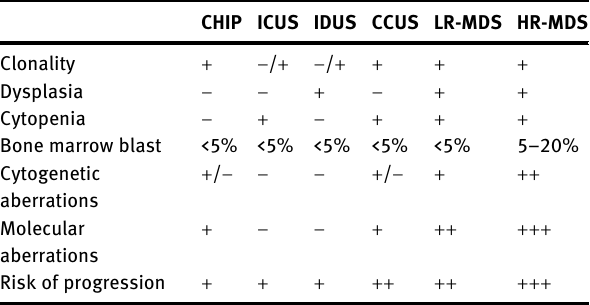
Table  : Characteristics of myeloid neoplasms and precursor lesions [ 